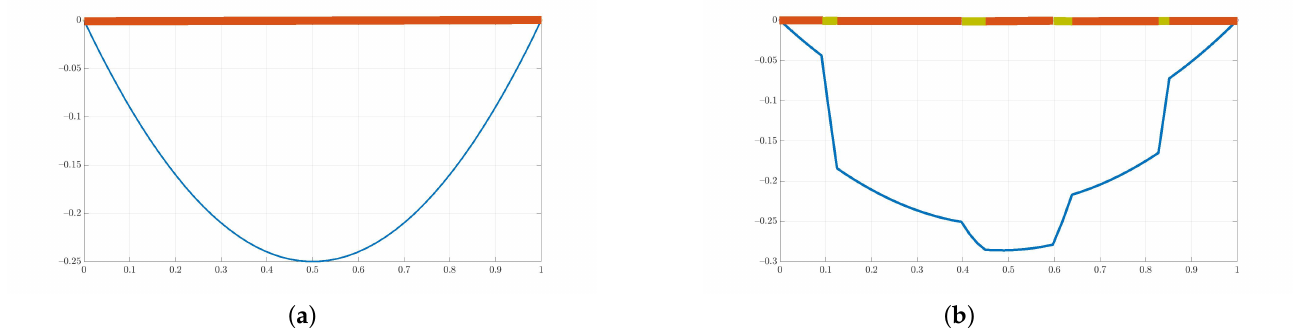
Figure 2. Exemplary “bubble” ( a ) standard and ( b ) modified shape functions for the unit 1D coarse